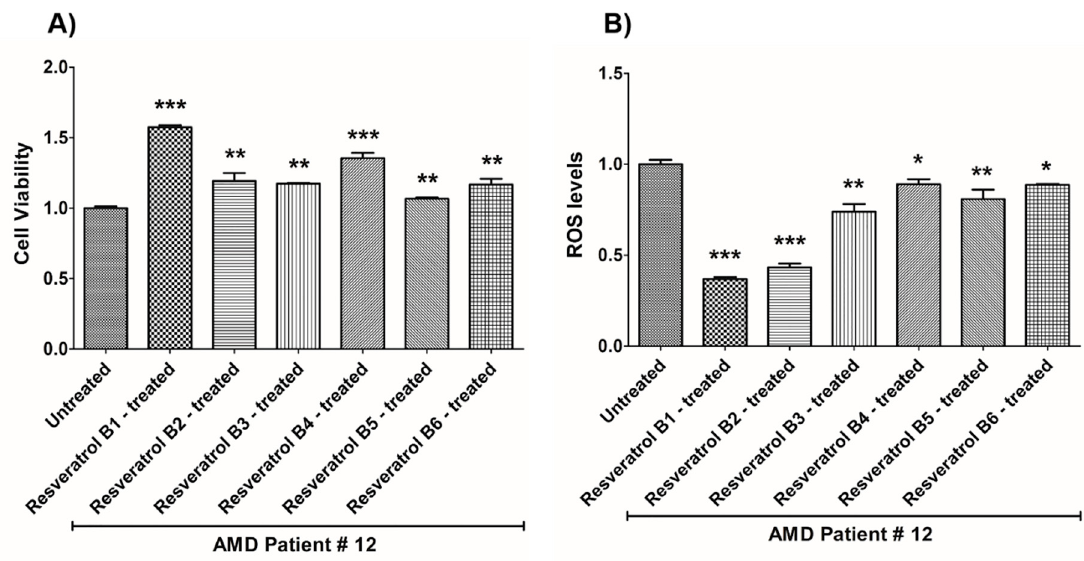
Figure 13. E ff ects of resveratrol formulations on cell viability ( A ) and ROS levels ( B ) in AMD patient #12.